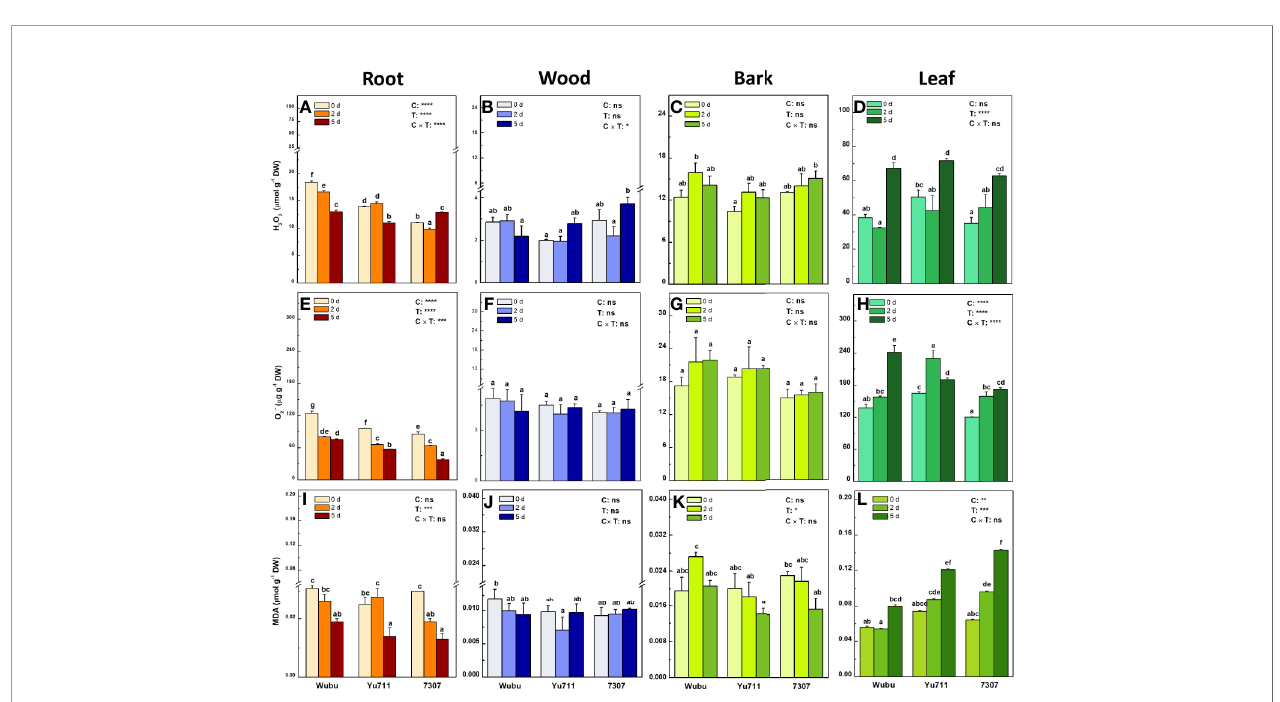
FIGURE 5 | Concentrations of H 2 O 2 (A – D) , O 2 (cid:129) − (E – H) and MDA (I – L) in roots, wood, bark, and leaves of mulberry cultivar Wubu, Yu711, and 7307 exposed to progressive drought stress for 0, 2, and 5 days (denoted as 0 d, 2 d, and 5 d), respectively. The bar indicates mean ± SE (n = 6). Different letters on the bars indicate signi fi cant difference. ANOVAS of cultivars (C), time (T) and their interaction (C × T) are also indicated. * P < 0.05; ** P < 0.01; *** P < 0.001; **** P < 0.0001; ns, not signi fi cant.